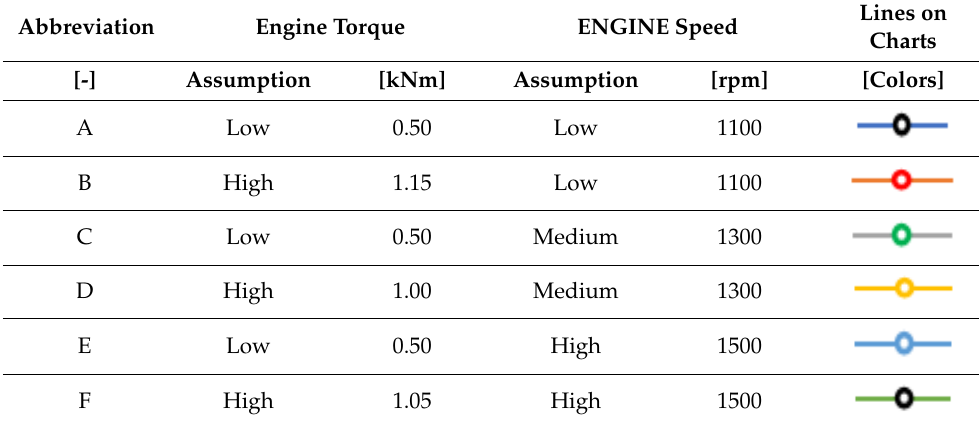
Table 2. The definitions of research parameters in engine tested phases. Abbreviation